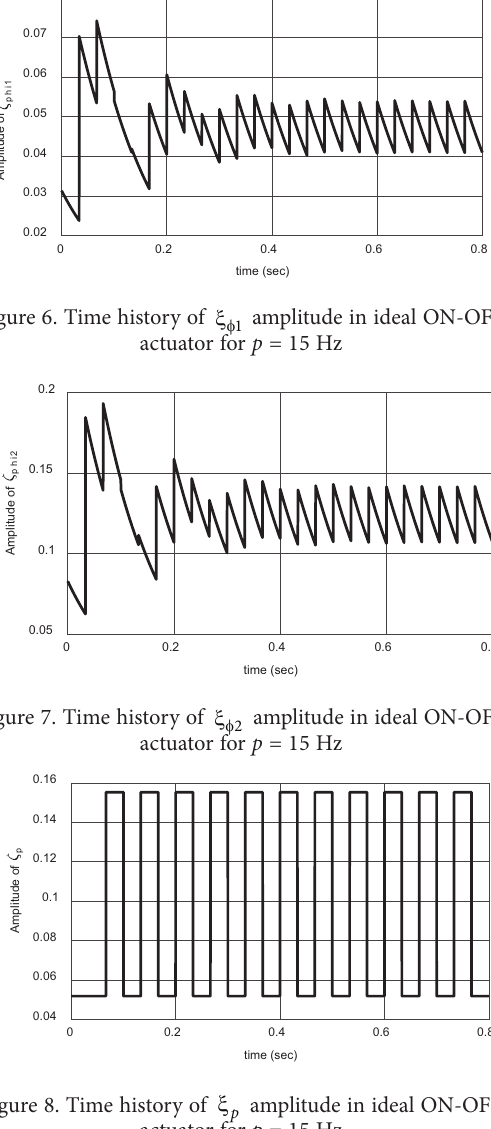
Figure 11. Roll rate eff e ct on time history of p ξ amplitude in ideal ON-OFF